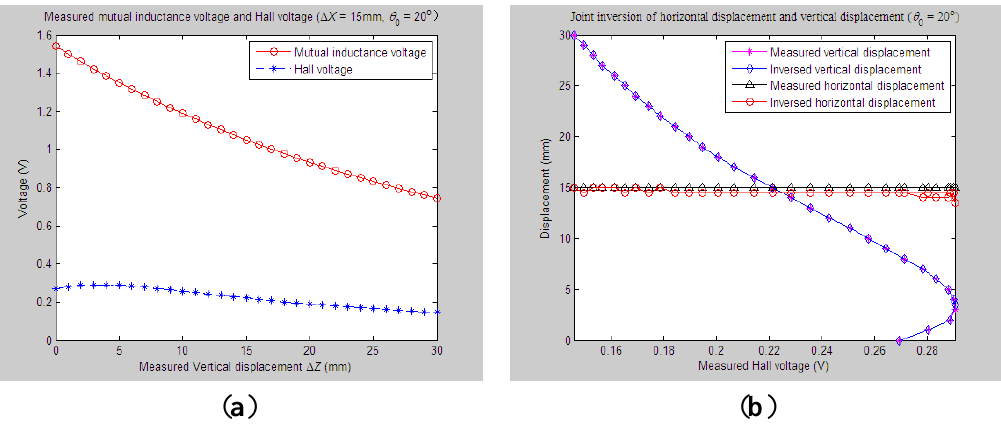
Figure 15. Horizontal and vertical displacement joint inversion results when measured Δ Z are changed, while measured Δ X remain stable ( θ 0 = 20°, Δ X = 15 mm). ( a ) Measured mutual inductance voltage and Hall voltage; ( b ) inversed horizontal and vertical